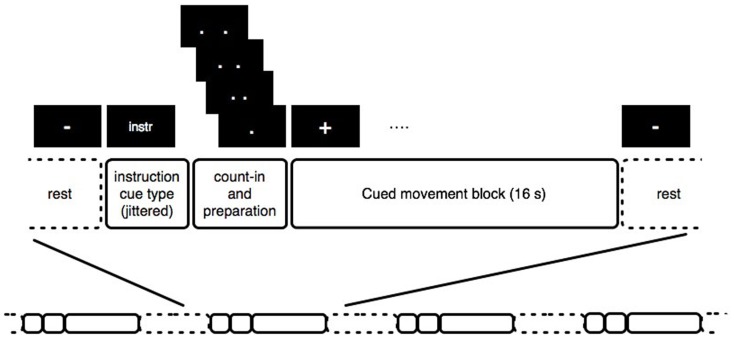
Graphical representation of the stimulus structure.